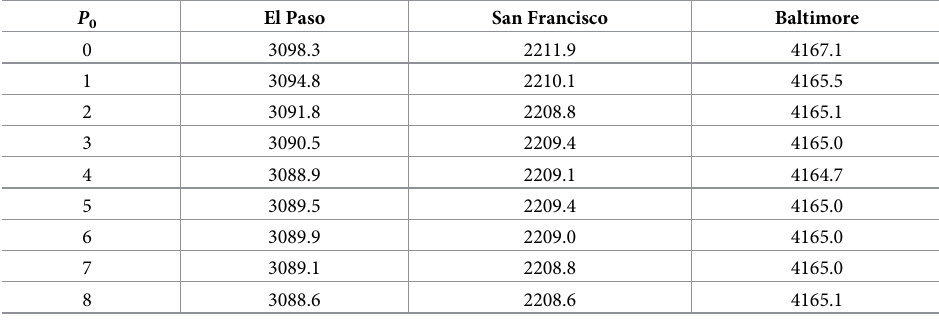
Table 7. Total equivalent source energy for heating, cooling and lighting loads for cellular office model in El Paso, San Francisco and Baltimore for varying positions of the control point P 0 in optimal shadings. P